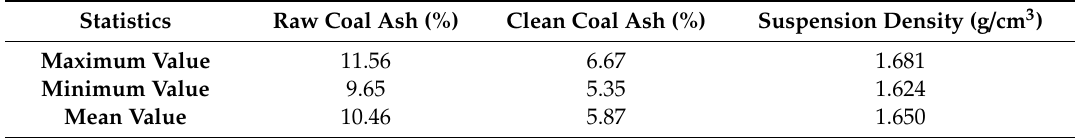
Table 1. Data set statistics table.